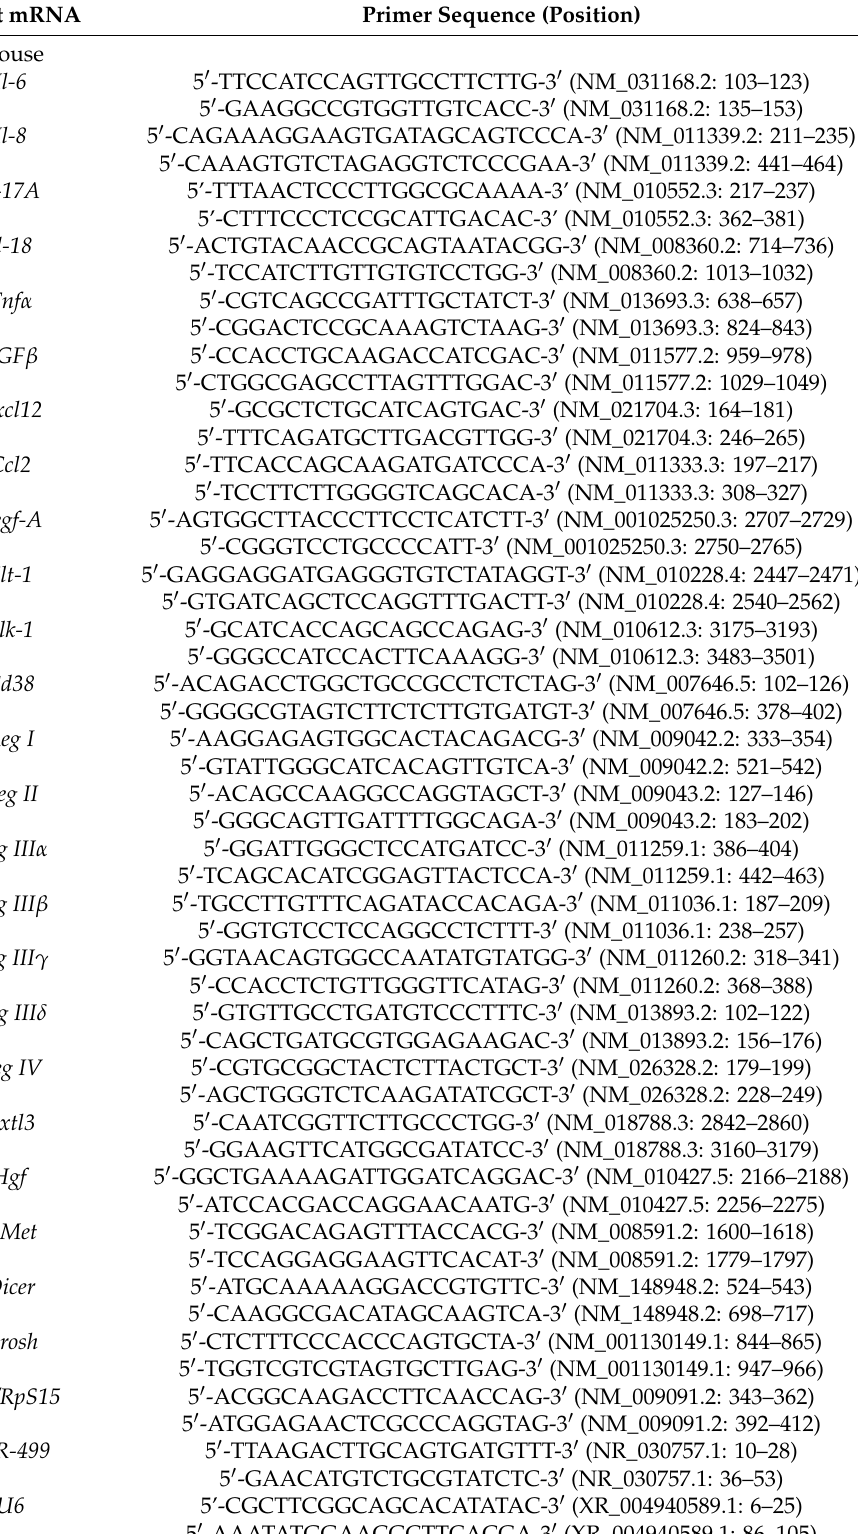
Table 1. Cont. Target